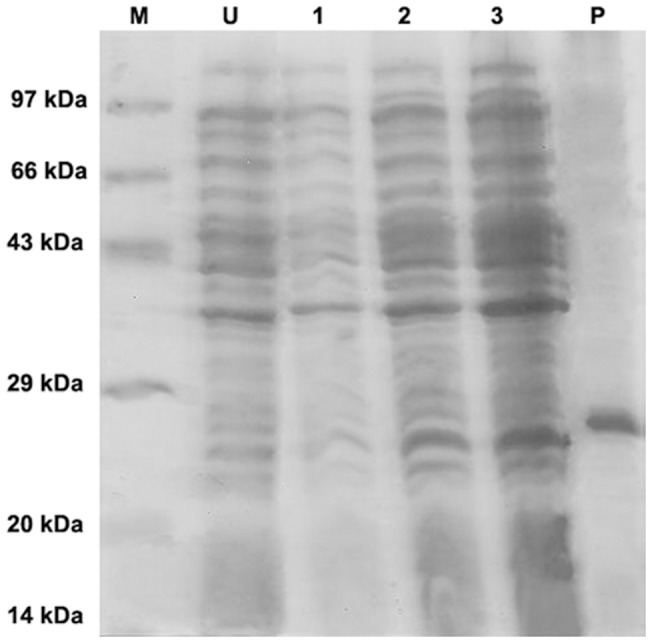
SDS-PAGE analysis of protein expression in culture.The uninduced and induced stages of expression of osmotin protein was resolved on 12% gel and stained with Coomassie brilliant blue. Lane M was loaded with Molecular weight marker. Lane U uninduced protein expression. Lane 1, 2, 3 shows expression after induction for 1 h, 2 h, 3 h respectively and lane P represents purified protein.